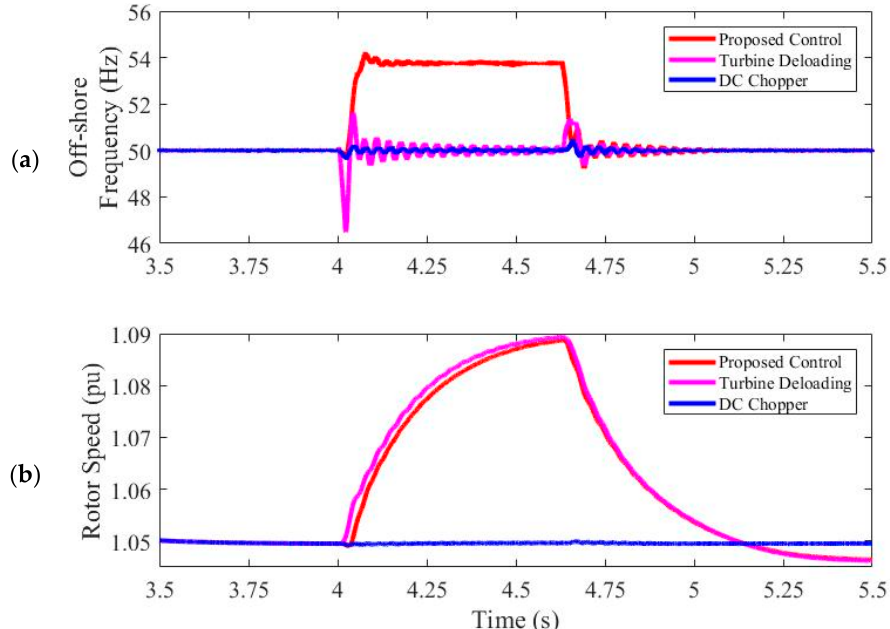
Figure 14. Simulation results of the on-shore fault scenario with a 2.95 Ω fault resistance. ( a ) On-shore AC voltage for each simulation case. ( b ) Off-shore AC voltage for each simulation case. ( c ) Rectifier-side DC voltage for each simulation case.